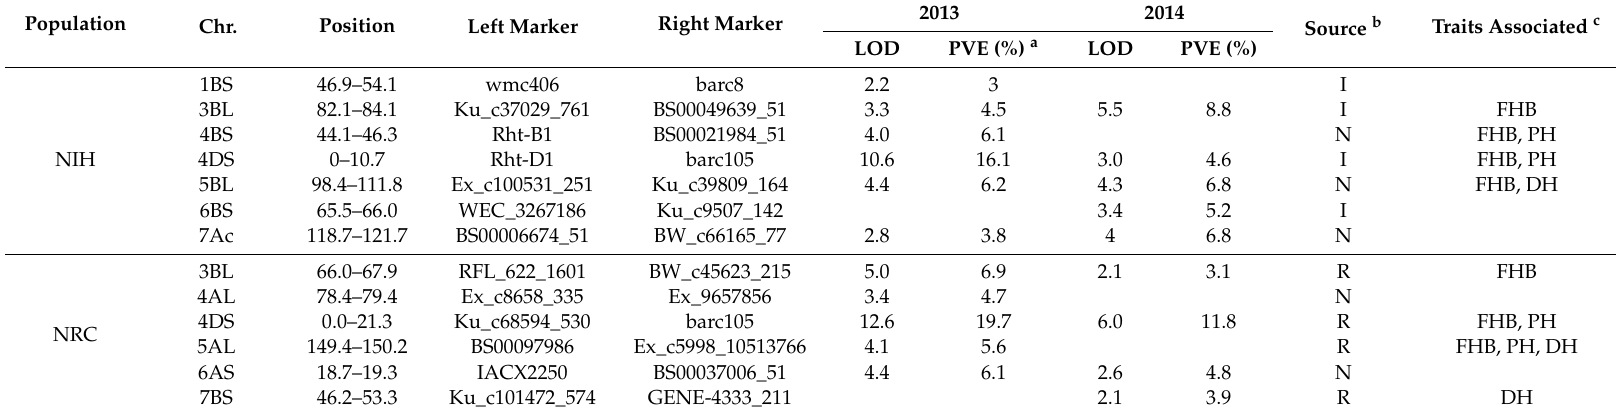
Table 3. QTL for anther extrusion in “NASMA” × “IAS20*5 / H567.71” (NIH) and “NASMA” × “RPB709.71 / COC” (NRC) populations and their association with other